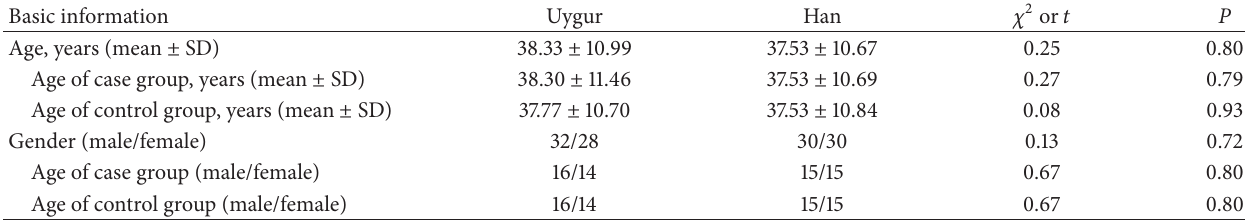
Table 1: The age and gender of subjects investigated in the case and control groups.